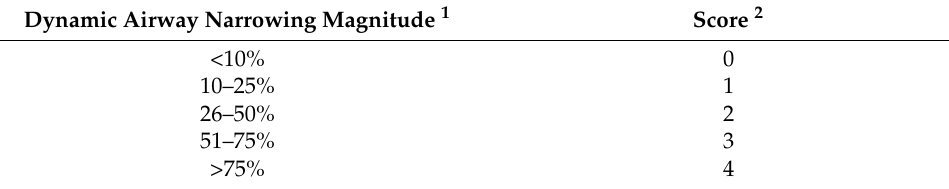
Table 1. Score assignment (0–4) for both inspiratory and expiratory breath-hold computed tomo- graphic (CT) measurement and tracheobronchoscopic grades of airway collapse to facilitate com- parison between these two imaging modalities. The scoring system was based on a modification of Tangner’s original tracheal collapse scores